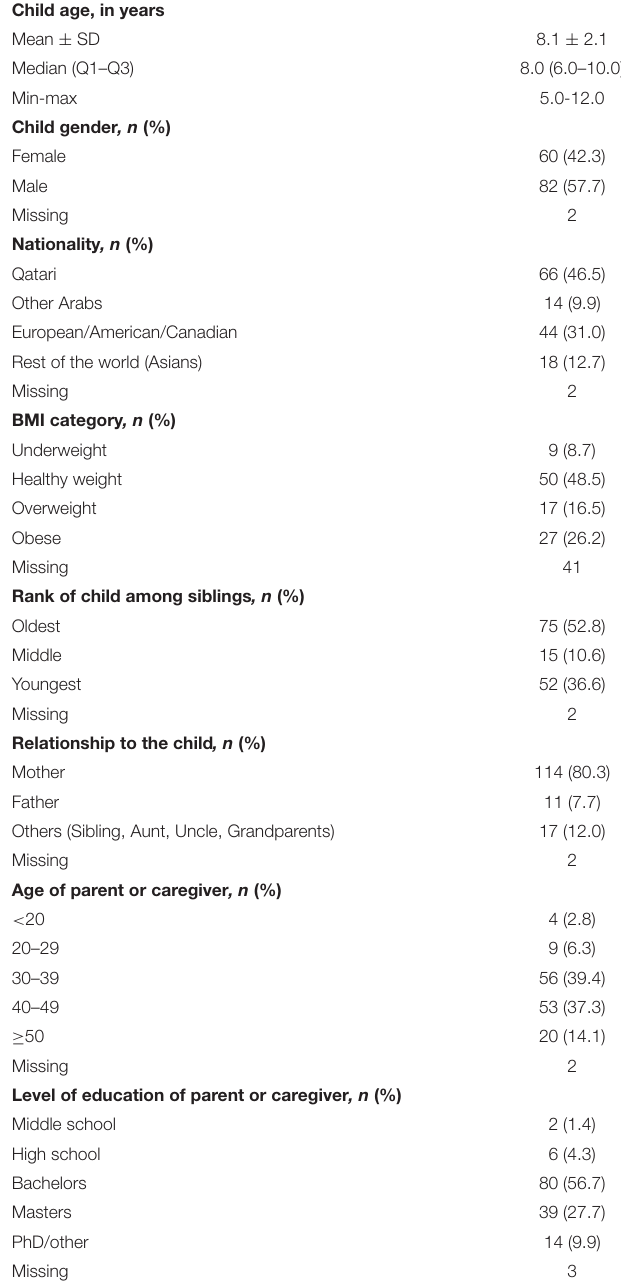
TABLE 1 | Descriptive data for demographic